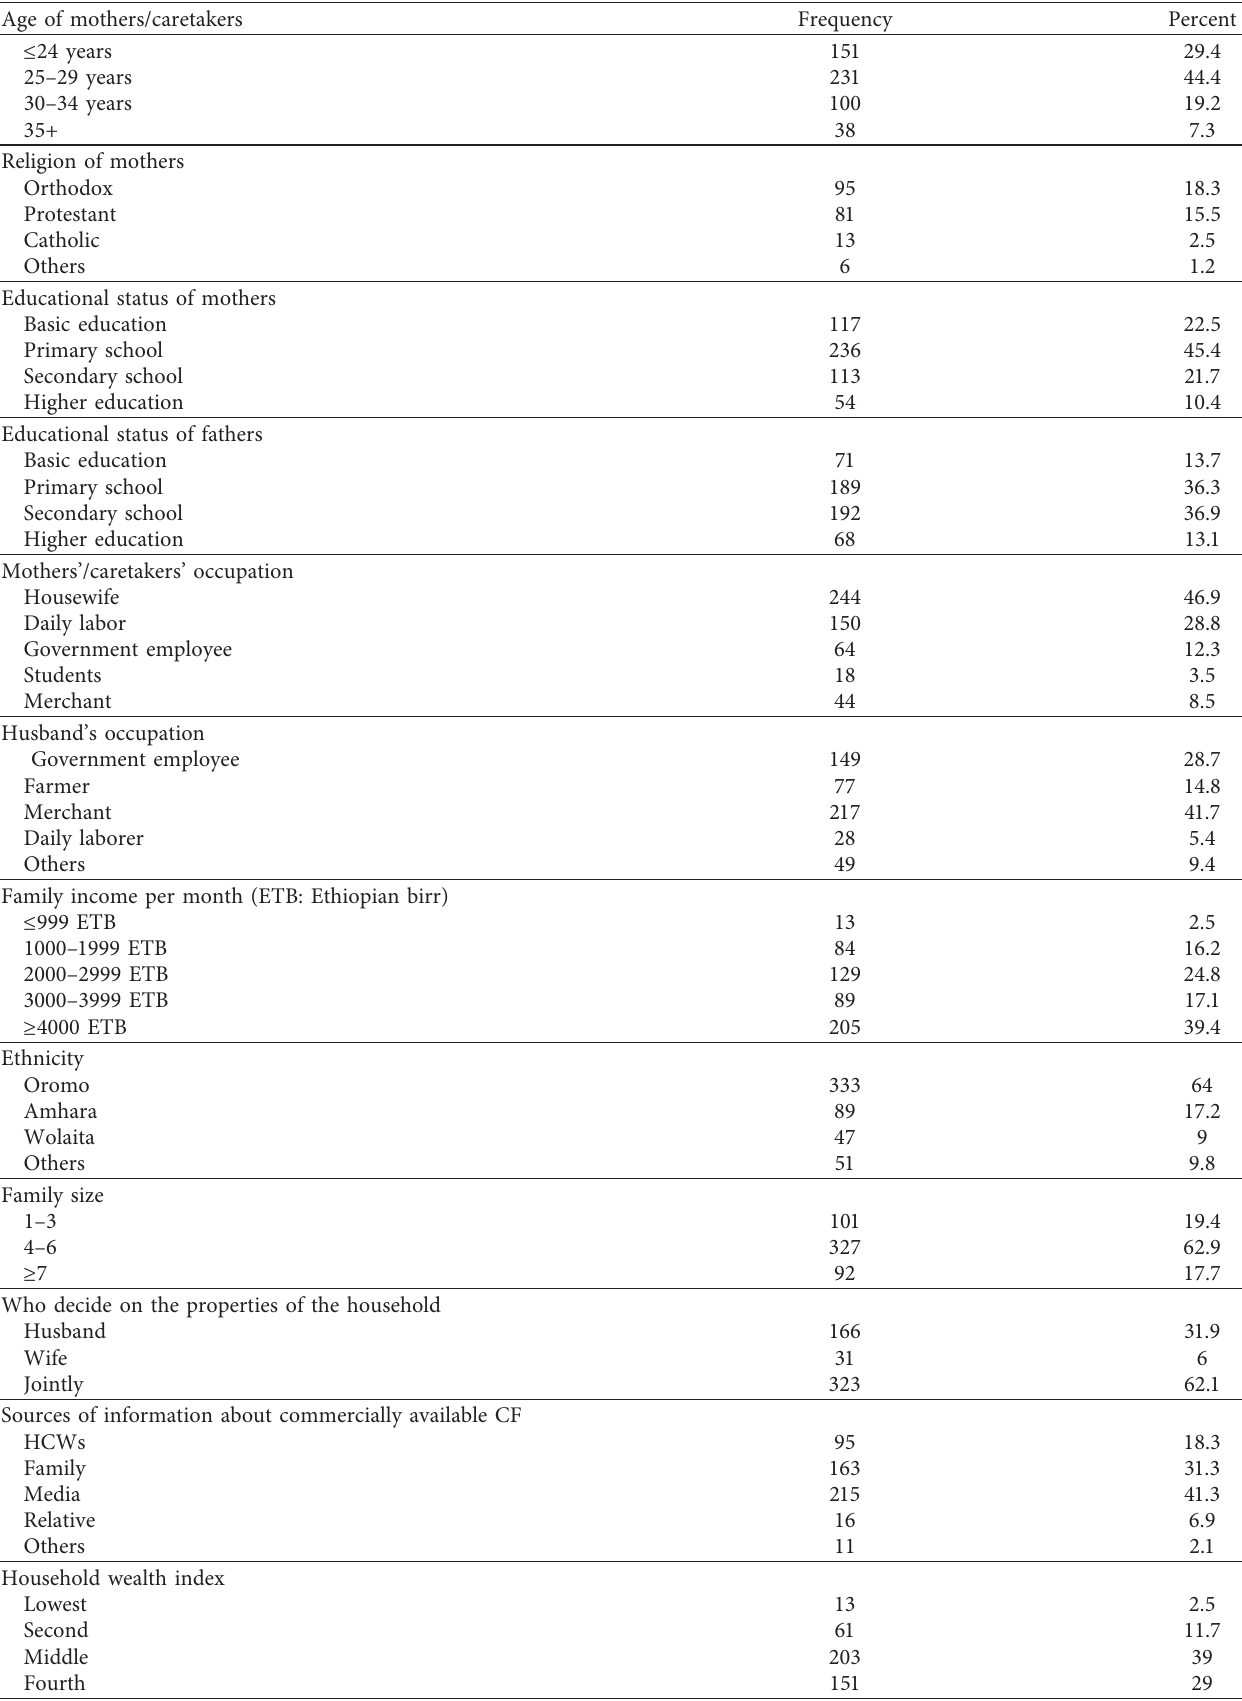
Table 1: Sociodemographic characteristic of mothers with children of 6–23 months, in Shashemene city, Oromia, Ethiopia, 2020 ( n � 520). Age of